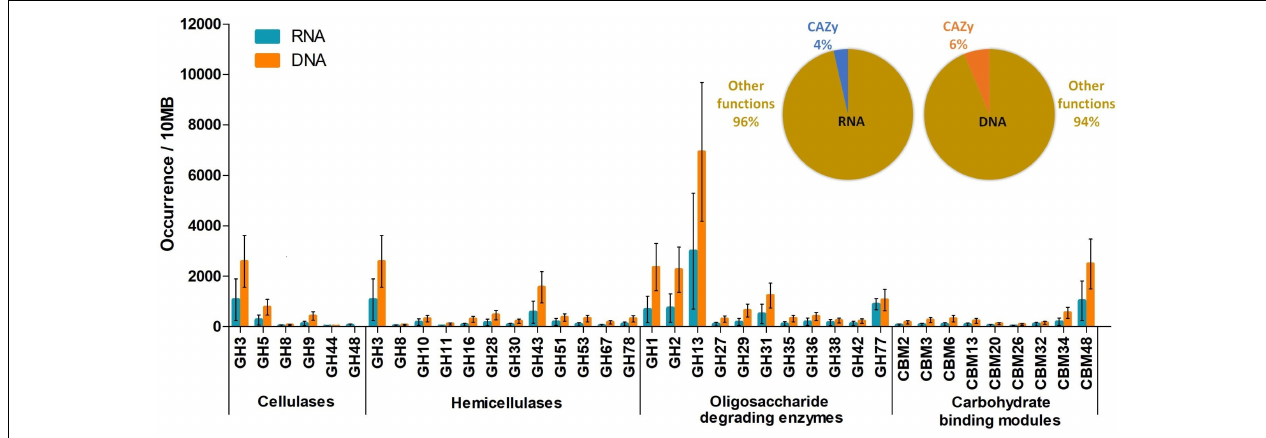
FIGURE 3 | Glucoside hydrolase enzyme families identified in the DNA and RNA datasets, respectively. The inset indicates the proportion of GH sequences relative to the total read